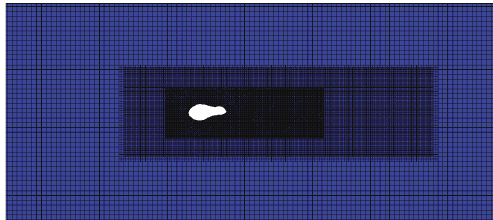
Figure 2: Computation domain model of asymmetric cross- section